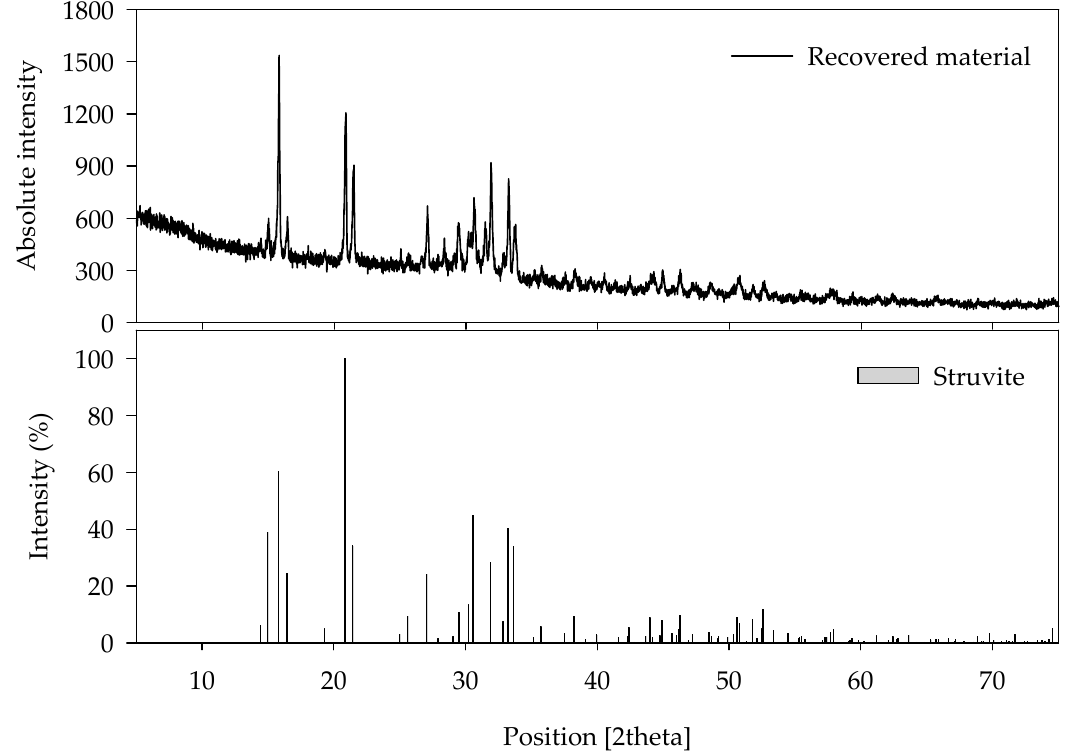
Figure 5. X-ray diffractogram (XRD) comparing recovered material with pure struvite.